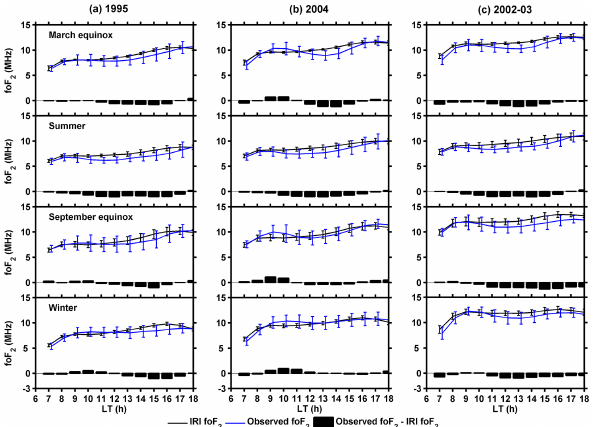
Figure 5. Seasonal variations of (a) f o F 2 , (b) f o F 3 , and (c) f o F 3 – f o F 2 , shown in the form of mean and SD, during different solar activity conditions (in different colors) observed at 10:00, 13:00 and 16:00LT (top to